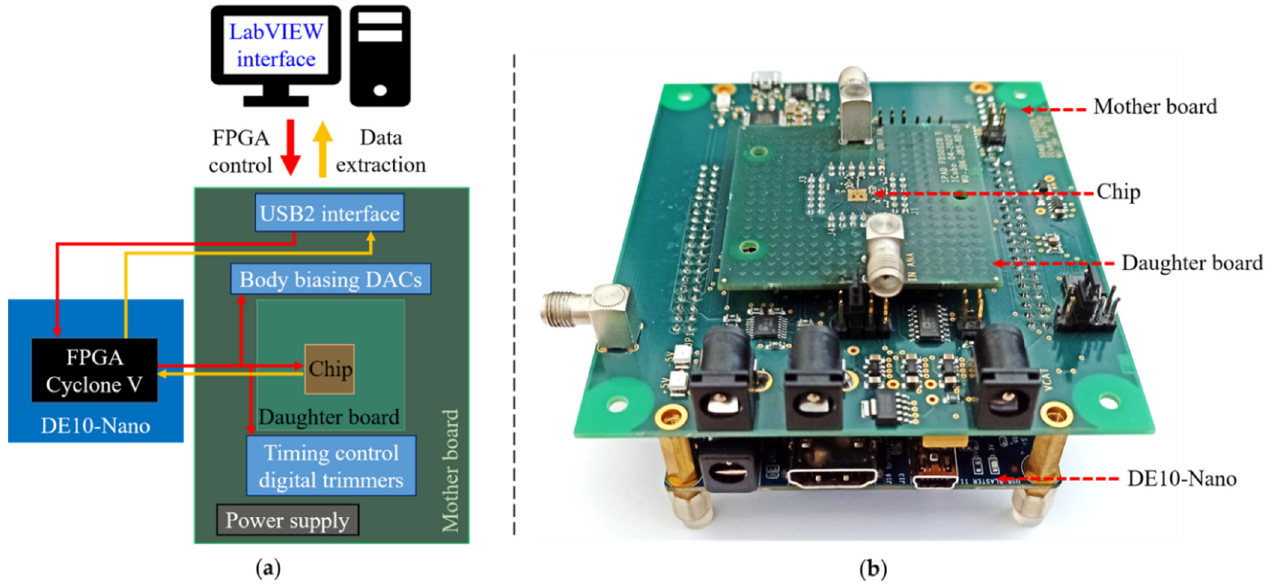
Figure 9. ( a ) Block diagram of the experimental setup; ( b ) photo of the experimental setup.